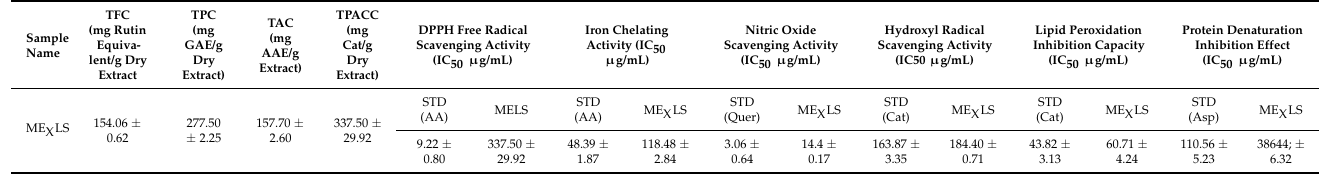
Figure 1. Gas chromatography-mass spectrometry profile of ME X LS was obtained from GC-MS with electron impact ionization (EI) method on a gas chromatograph (GC17A, Shimadzu Corpo- ration, Kyoto, Japan) coupled to a mass spectrometer (GC-MS TQ 8040, Shimadzu Corporation, Kyoto, Japan). Table 2. Comprehensive antioxidative effects of ME X